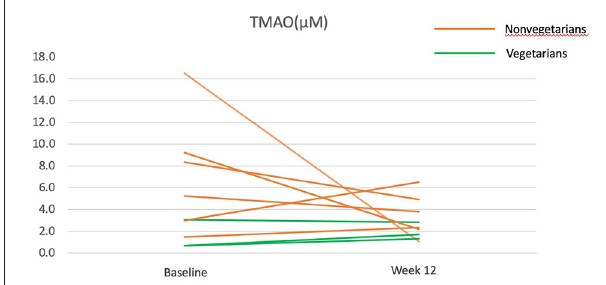
FIGURE 3 | Trimethylamine N-Oxide (TMAO) before and after the 12-week diet intervention. Green lines represent participants who were vegetarians at baseline. Orange lines represent participants who were nonvegetarians at